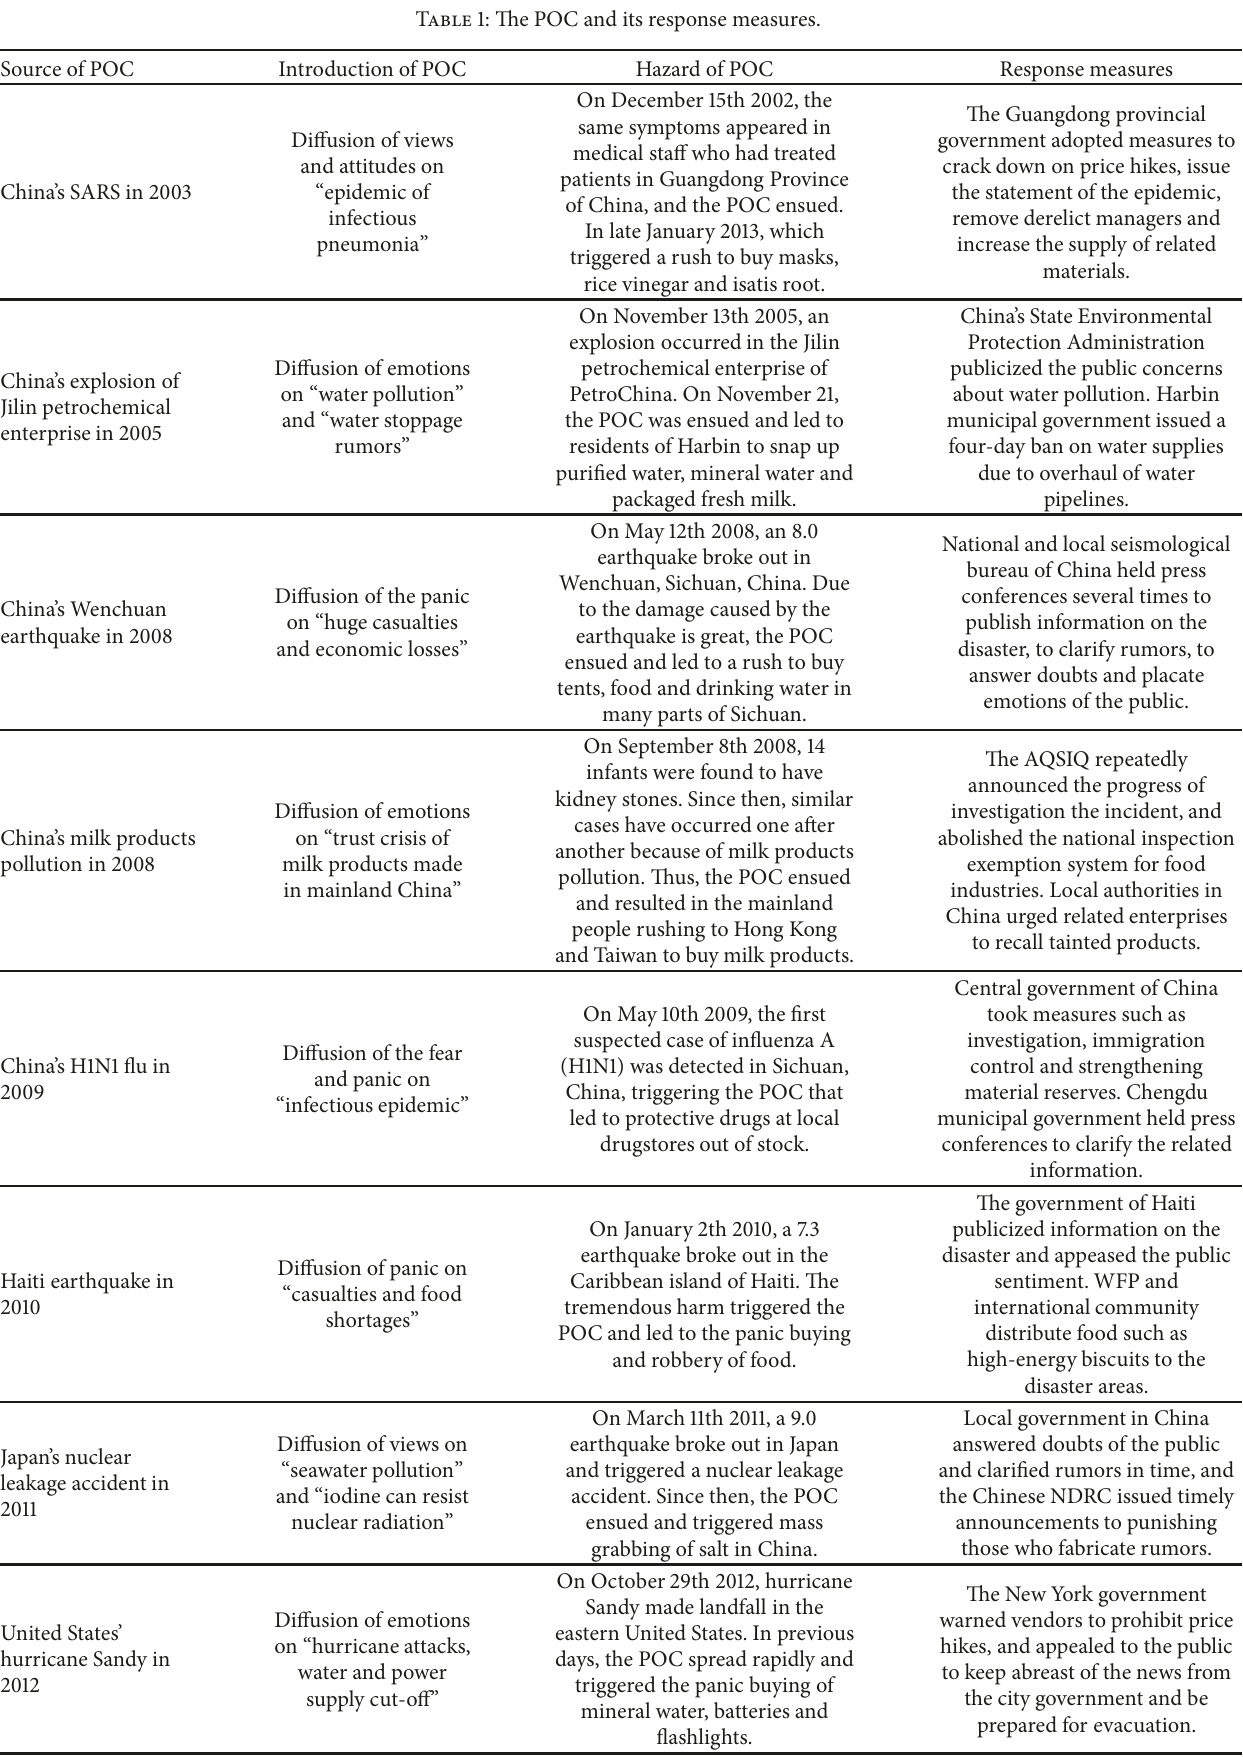
Table 1: The POC and its response